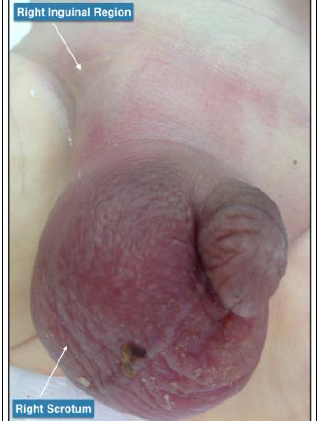
Figure 1: Preoperative images showing swollen and red right inguinoscrotal region on 3rd day of presentation. Right testis cannot be palpated separately.